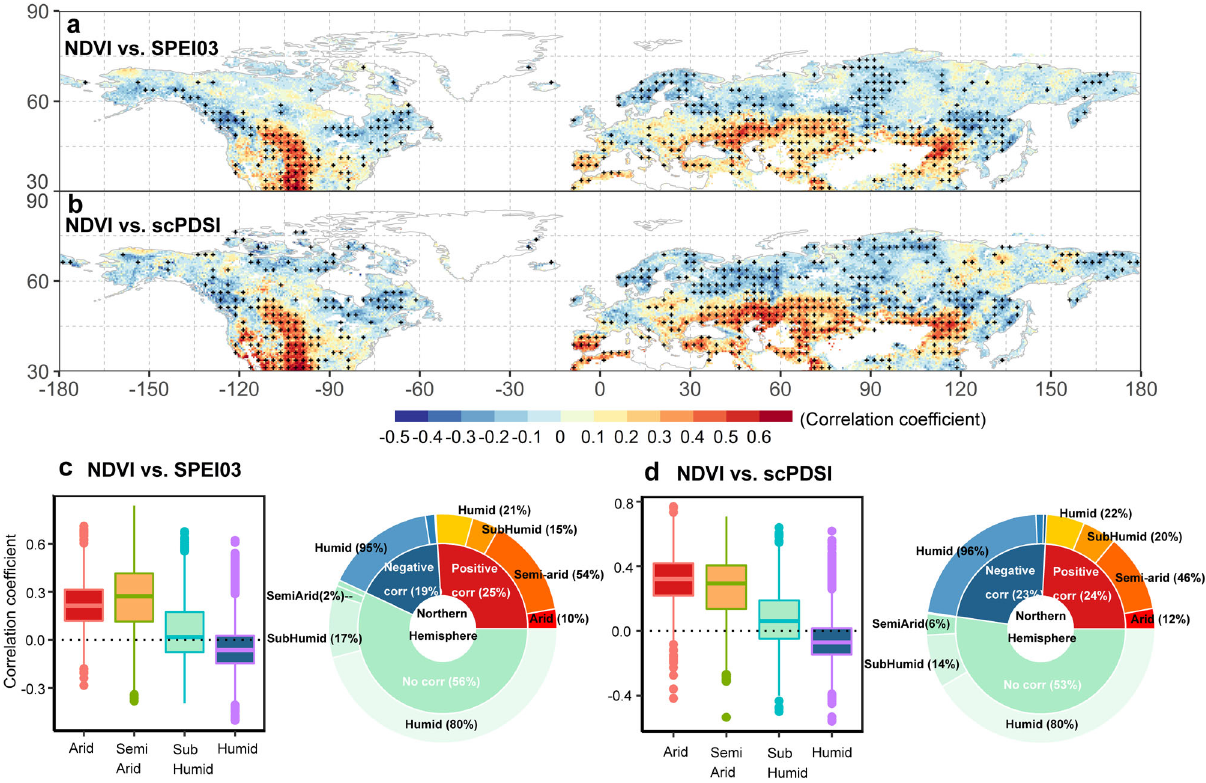
Fig. 1 Spatial distribution of the correlations between vegetation growth and water availability indices over the last three decades. a , b Show the spatial distribution of correlation coef fi cients (R NDVI-SPEI03 and R NDVI-scPDSI ) between normalized difference vegetation index (NDVI) anomaly and 3-month Standardized Precipitation-Evapotranspiration Index (SPEI03) and Palmer Drought Severity Index (scPDSI) for the entire study period. Black dots indicate signi fi cant Spearman correlations with p < 0.05; c , d are the statistical distributions of R NDVI-SPEI03 and R NDVI-scPDSI for arid, semi-arid, sub-humid, and humid regions, respectively. The maximum and minimum extents of the colored boxes indicate the 25 th and 75 th percentiles and the whiskers represent the 5 th and 95 th percentiles,